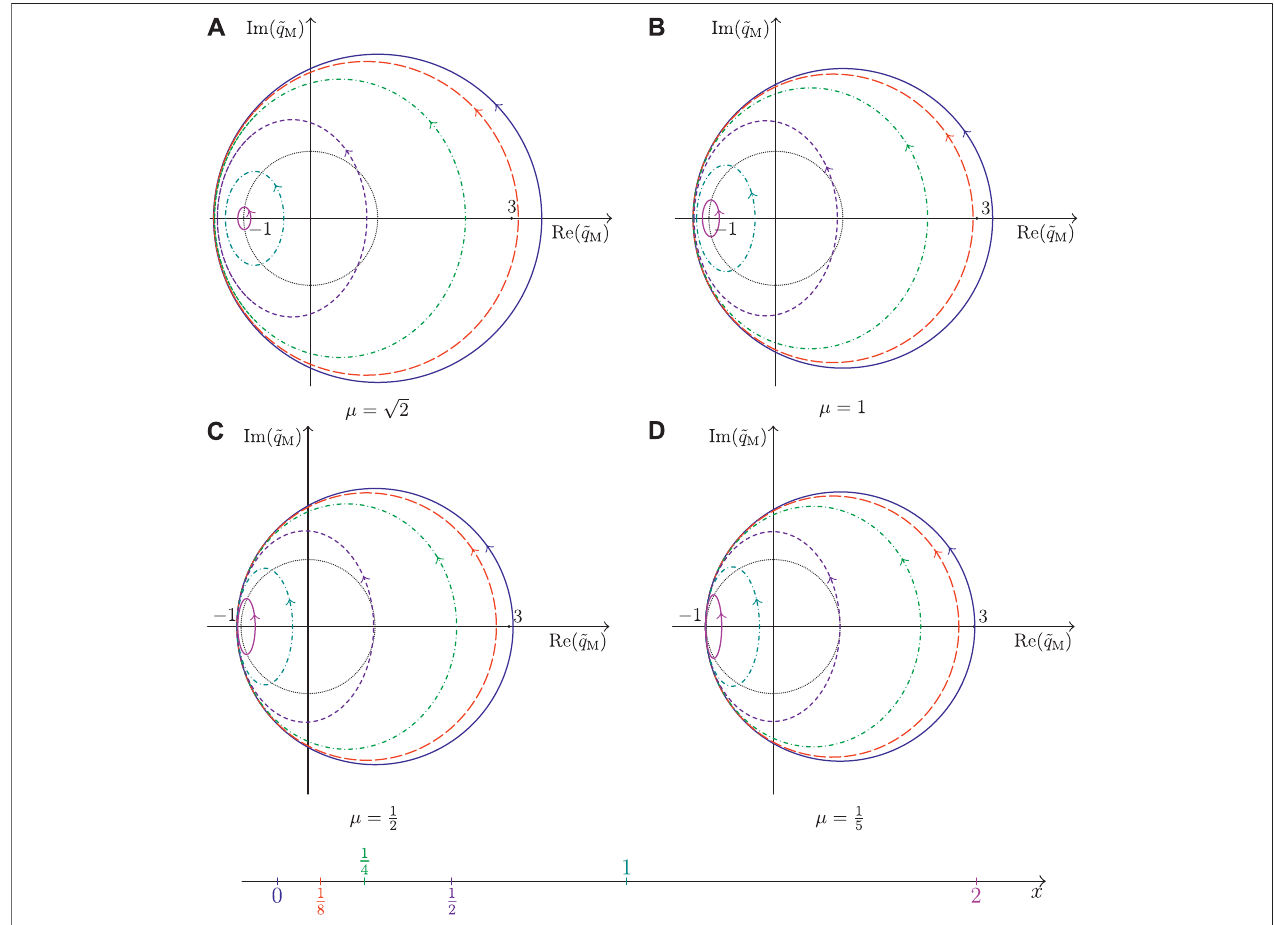
FIGURE 5 | Parameterization of the non-rapid oscillating complex-valued amplitude of the Kuznetsov-Ma breather ~ q M in the temporal variable t ( − π / ρ < t < π / ρ ) for different values of spatial variable x : x (cid:2) 0 (solid blue), x (cid:2) 1 / 8 (long-dashed red), x (cid:2) 1 / 4 (dash-dotted green), x (cid:2) 1 / 2 (dashed purple), x (cid:2) 1 (dash-dotted cyan), and x (cid:2) 2 (solid magenta) and different values of the parameter μ : (A) μ (cid:2)